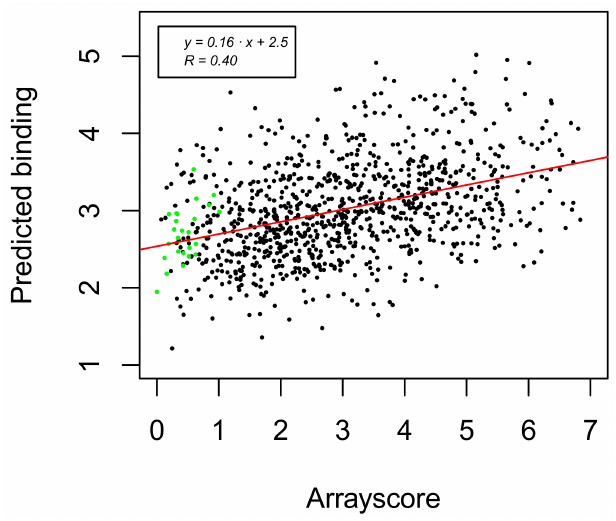
Figure 5. Predicted values for dimeric coiled coil formation binding as a correlation to the calculated arrayscore from fluorescence binding responses (low values indicate binding, while high values represent non-interacting coiled coil dimers). The line in the plot corresponds to the fit of calculated vs. experimental values; the green points mark the prediction of 25 coiled coils with determined K d